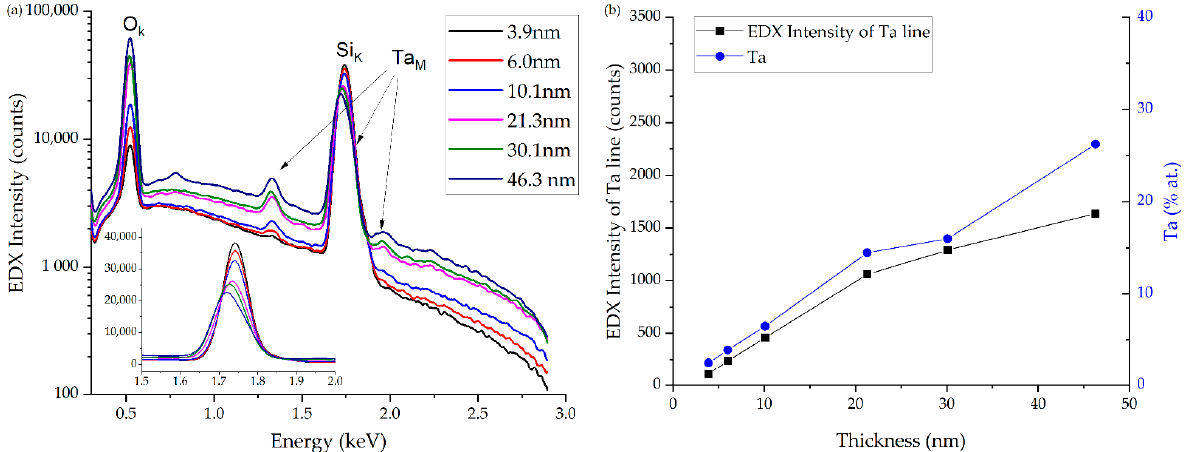
Figure 3. ( a ) EDX spectra of tantalum oxide samples of various thicknesses deposited on silicon with linear and logarithmic dependences. ( b ) Dependence of the 1.335 keV tantalum line intensity and atomic content on the film thickness.